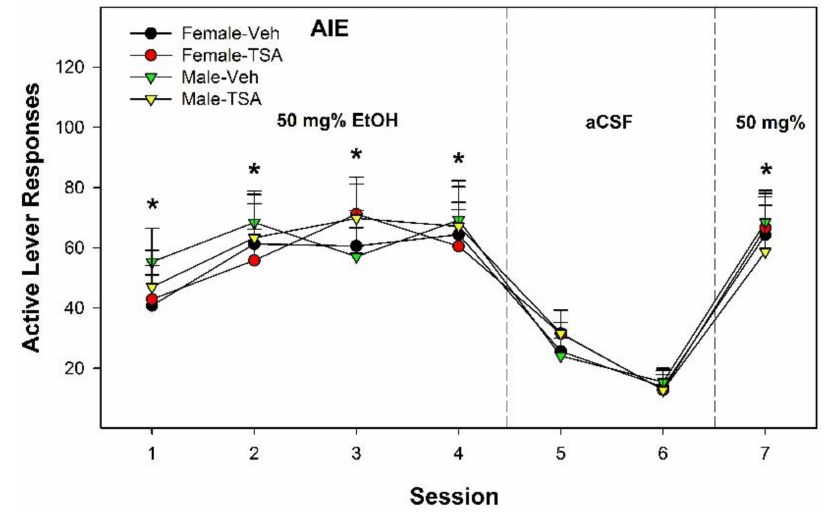
Figure 8. Active lever responses in male and female tP exposed to CON or AIE during adolescence and pretreatment/treatment with the HDAC inhibitor Trichostatin A (TSA) before testing for EtOH self-administration into the posterior VTA during adulthood. * indicates lever discrimination between active and inactive lever. There was no evidence that TSA modified EtOH self-administration into the posterior VTA in tP rats. Data are mean ±